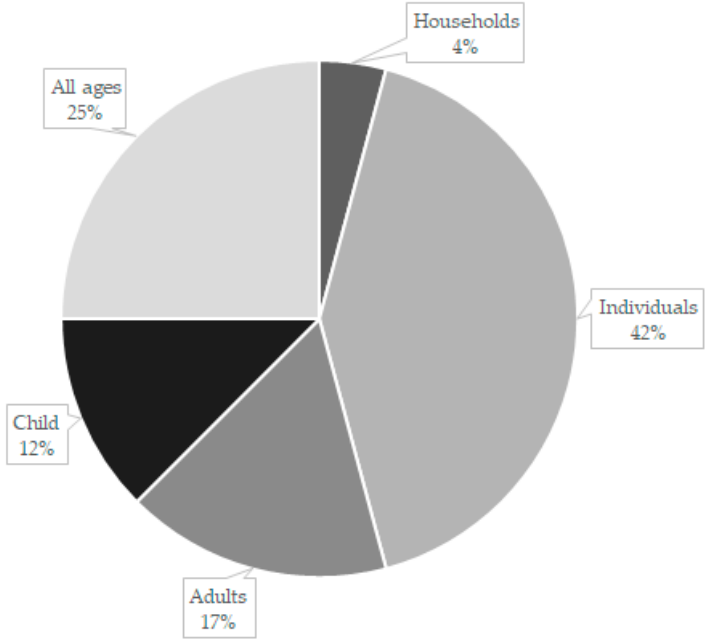
Figure 2. Cohort demographics.